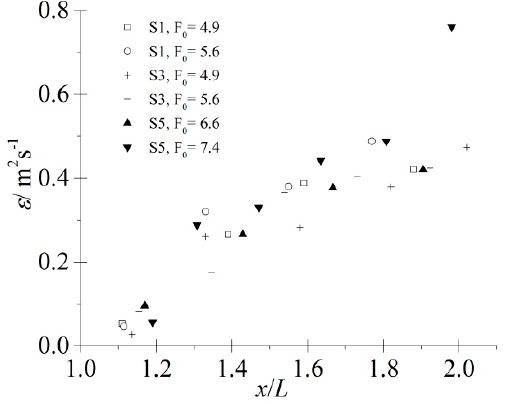
Figure 6. Calculated values of turbulent energy dissipation rate ε on the chute bottom.